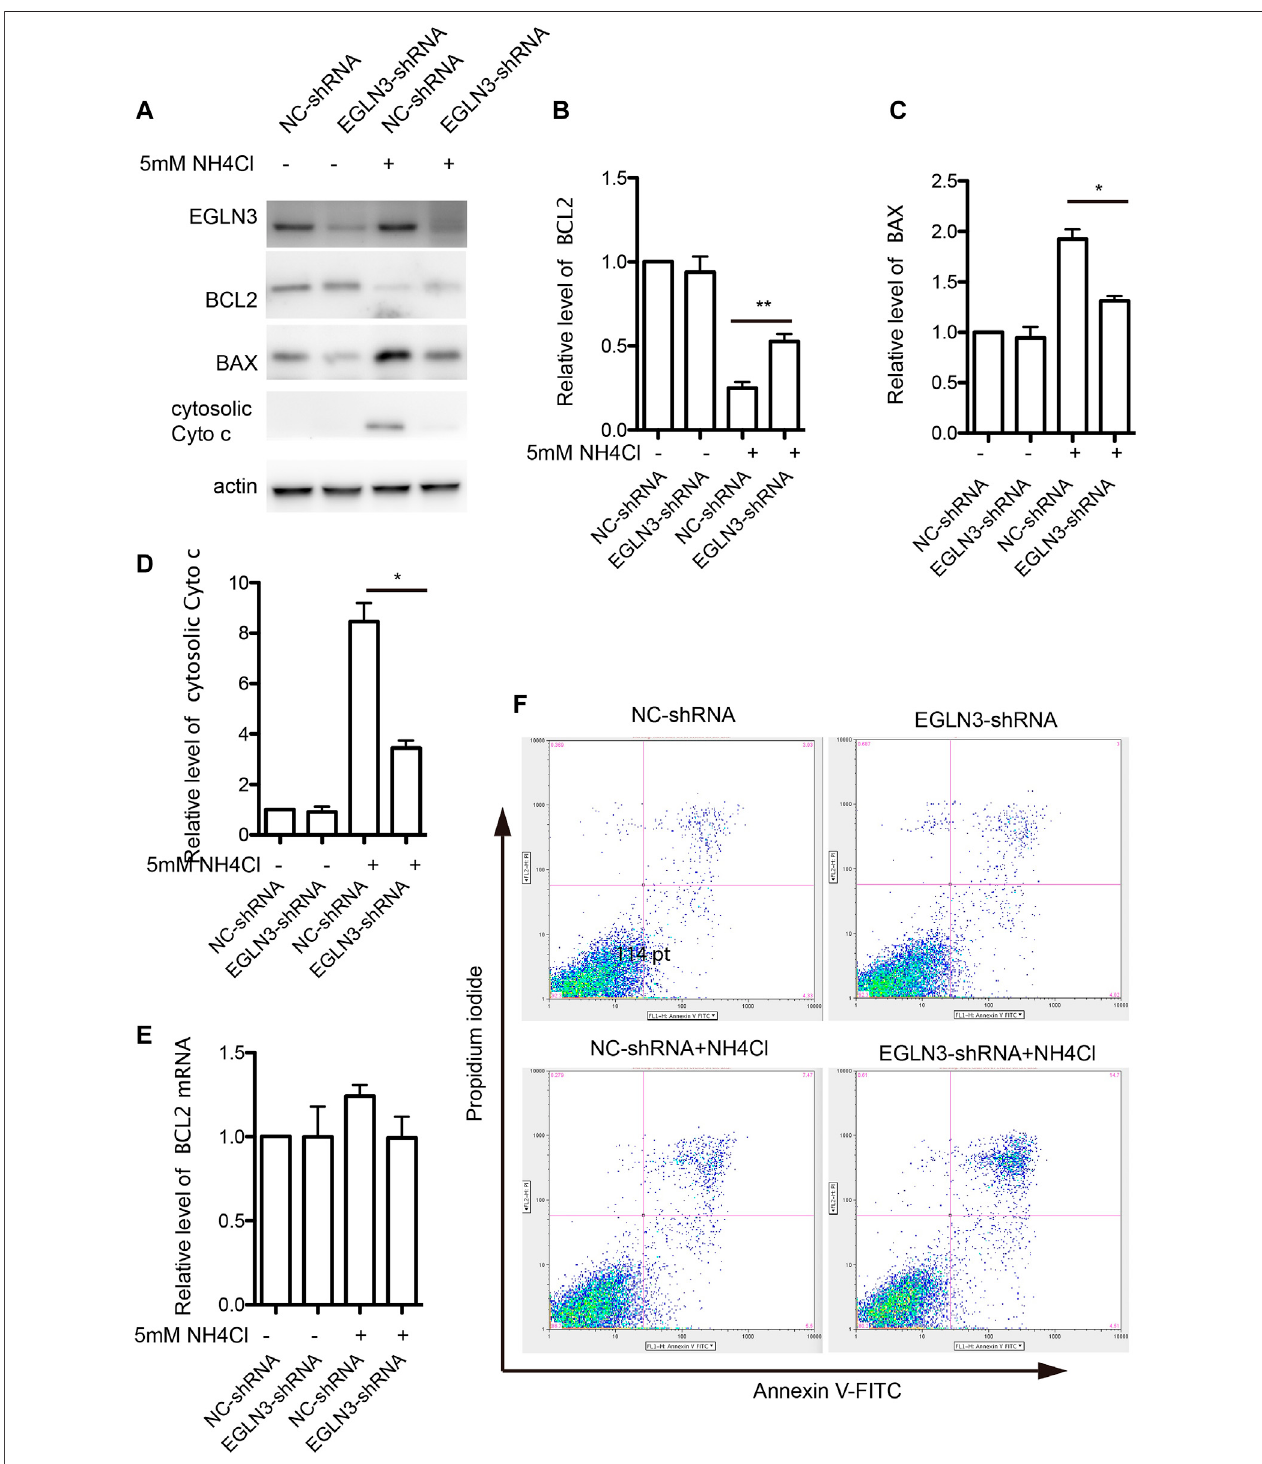
FIGURE 5 | EGLN3 inhibition attenuated mitochondrial apoptosis activation induced by NH 4 Cl exposure. (A) Western blot was performed to examine the protein levels of mitochondrial apoptosis proteins Bcl-2, Bax and cytosolic cytochrome c in neurons subjected to NH 4 Cl insult. Actin was as a loading control. EGLN3 knockdown signi fi cantly attenuated ammonia induced down-regulated expression of Bcl-2, up-regulated expression of Bax and release of cytochrome c into the cytosol. (B) Quantitation (Mean ± SEM) of Bcl-2 expression from three independent experiments. EGLN3 inhibition ameliorated decreased expression of Bcl-2 during NH 4 Cl exposure. (C) Quantitation (Mean ± SEM) of Bax expression from three independent experiments. EGLN3 inhibition ameliorated increased expression of